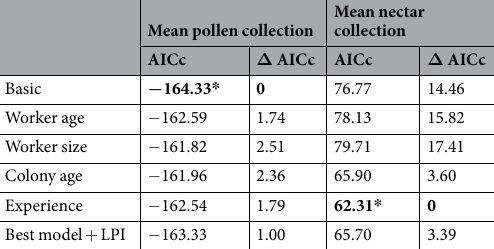
significantly positively correlated with number of days spent foraging (Fig. 2a). As faster learning bees (i.e. those that made fewer errors) had lower LPI values, our results indicate that faster learners foraged for fewer days. The number of days on which bees foraged appeared to be a good proxy measure of individual foraging lifespan, because once a bee began foraging in the field they almost all (92%) continued foraging for consecutive days until the end of their life. We assume foraging continued until death because the period for which they were away from the colony increased as they approached their final foraging bout (Fig. S5), a likely consequence of senescence 31 .